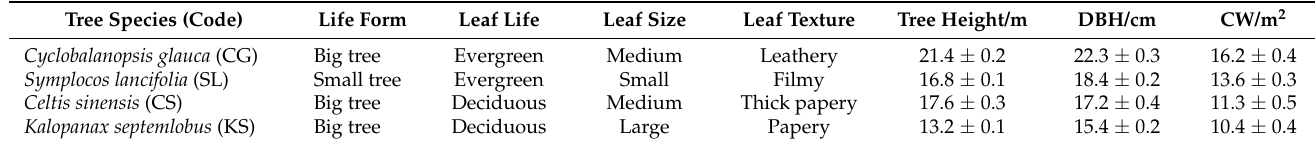
Table 1. Information for four sampling trees in Maolan. DBH is the diameter at breast height. CW is the canopy width of a tree. The number after “ ± ” represents the standard